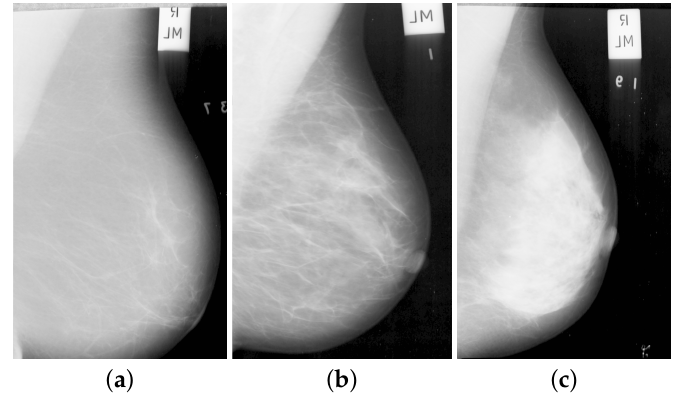
Figure 1. Example mammographic tissue types: ( a ) fatty, ( b ) glandular, and ( c ) dense